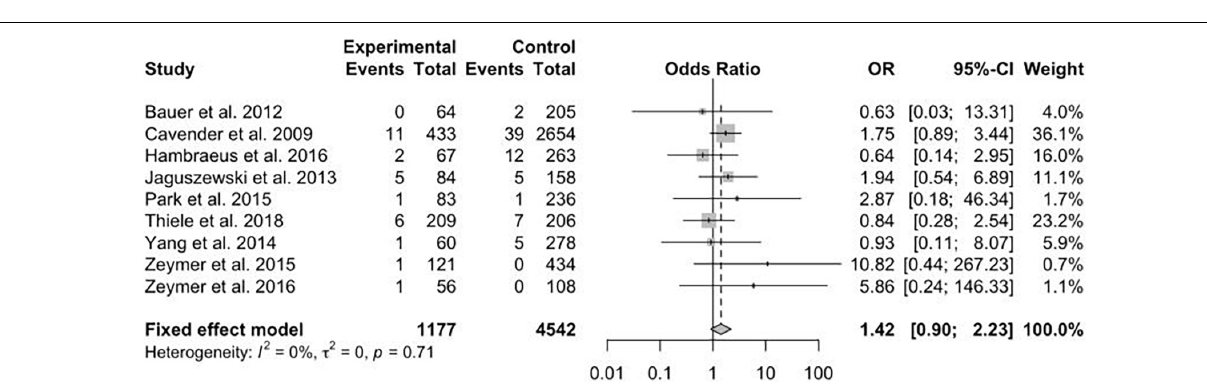
FIGURE 9 | Stroke with multivessel (MV) vs. culprit vessel-only (CO) percutaneous coronary intervention (PCI) in patients with ST-segment elevation myocardial infarction (STEMI) complicated by cardiogenic shock